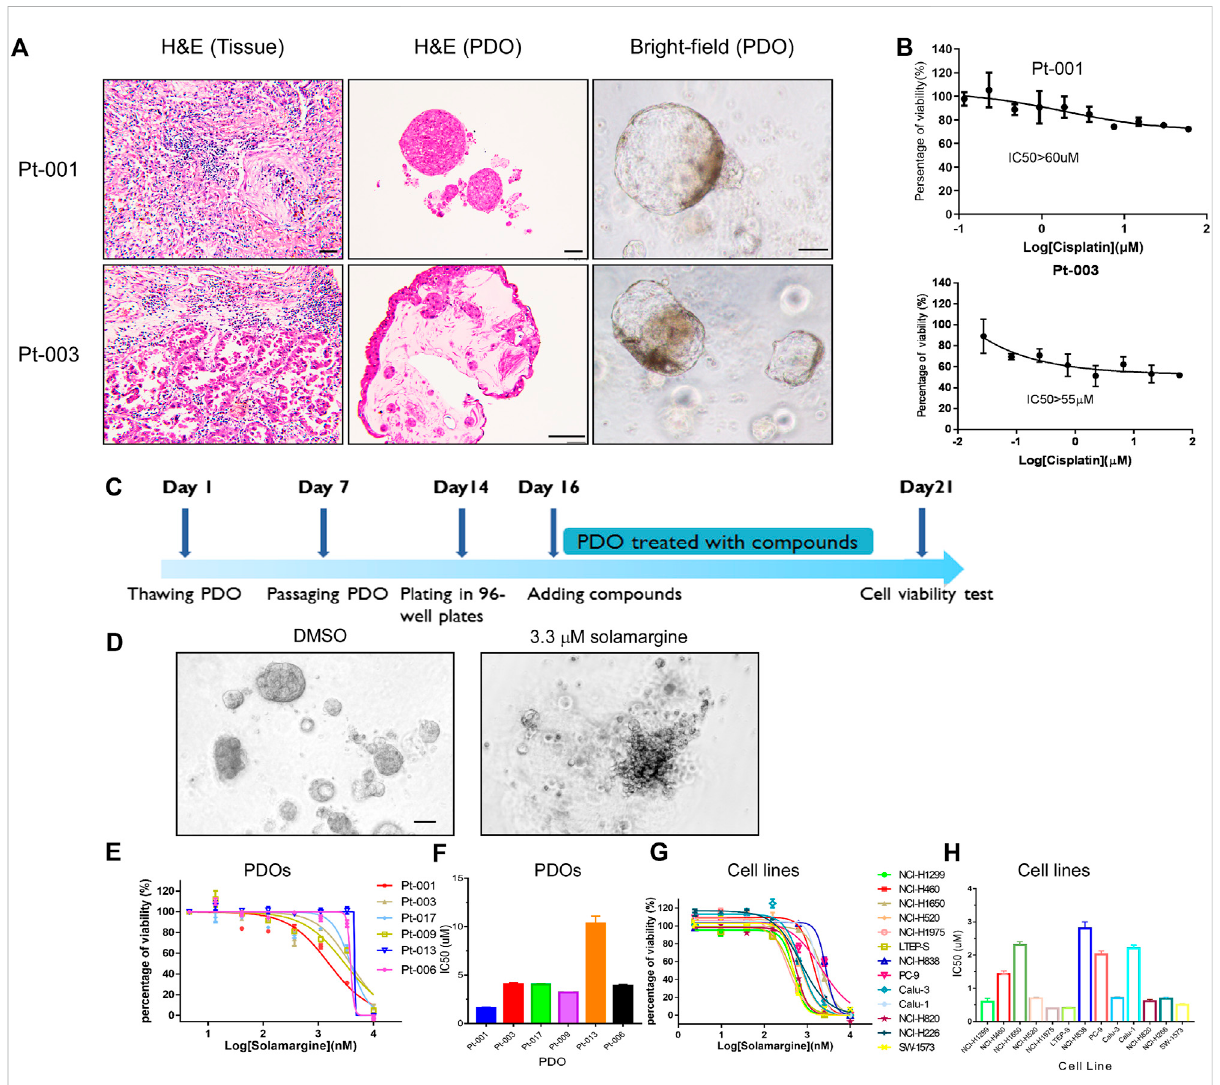
FIGURE 1 Solamargine is a potential anti-tumor agent in Cisplatin-resistant cells. (A) Representative histologyof primary lung cancer tissue and their tumor-derived organoids. Left and middle images are the morphology of Pt-001 and Pt-003 primary tumor tissues and their derived organoids by H&E staining. Right images are the Pt-001 and Pt-003-derived organoids in bright- fi eld. Original magni fi cation ×200, scale bar 200 μ m. (B) The dose-responsecurveofCisplatintoPt-001andPt-003organoids.N=3. (C) Thetreatmentschemeofdrugscreeningusinglungcancerpatients derived organoids. (D) Morphological change of lung cancer patients derived organoids when treated with DMSO or 3.3 μ M Solamargine for 5 days. (E – H) Thedose-responsecurveofSolamarginewasevaluatedinthirteenlungcancercelllinesandsixlungcancerpatienttumor-derivedorganoids, respectively. Cell lines and organoids were treated for 5